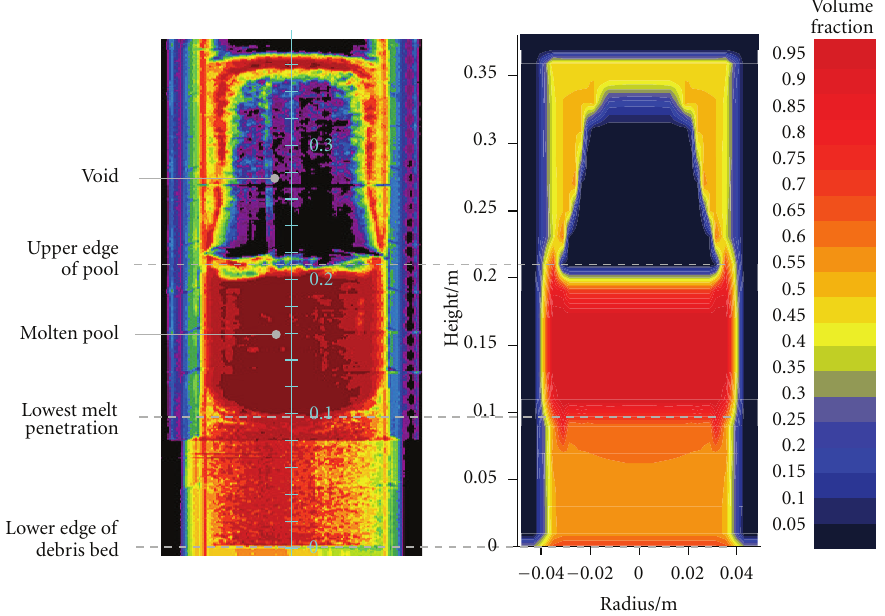
Figure 8: Comparison of Ph´ebus FPT4 post-test radiography (left) with calculated volume fraction of material (right).